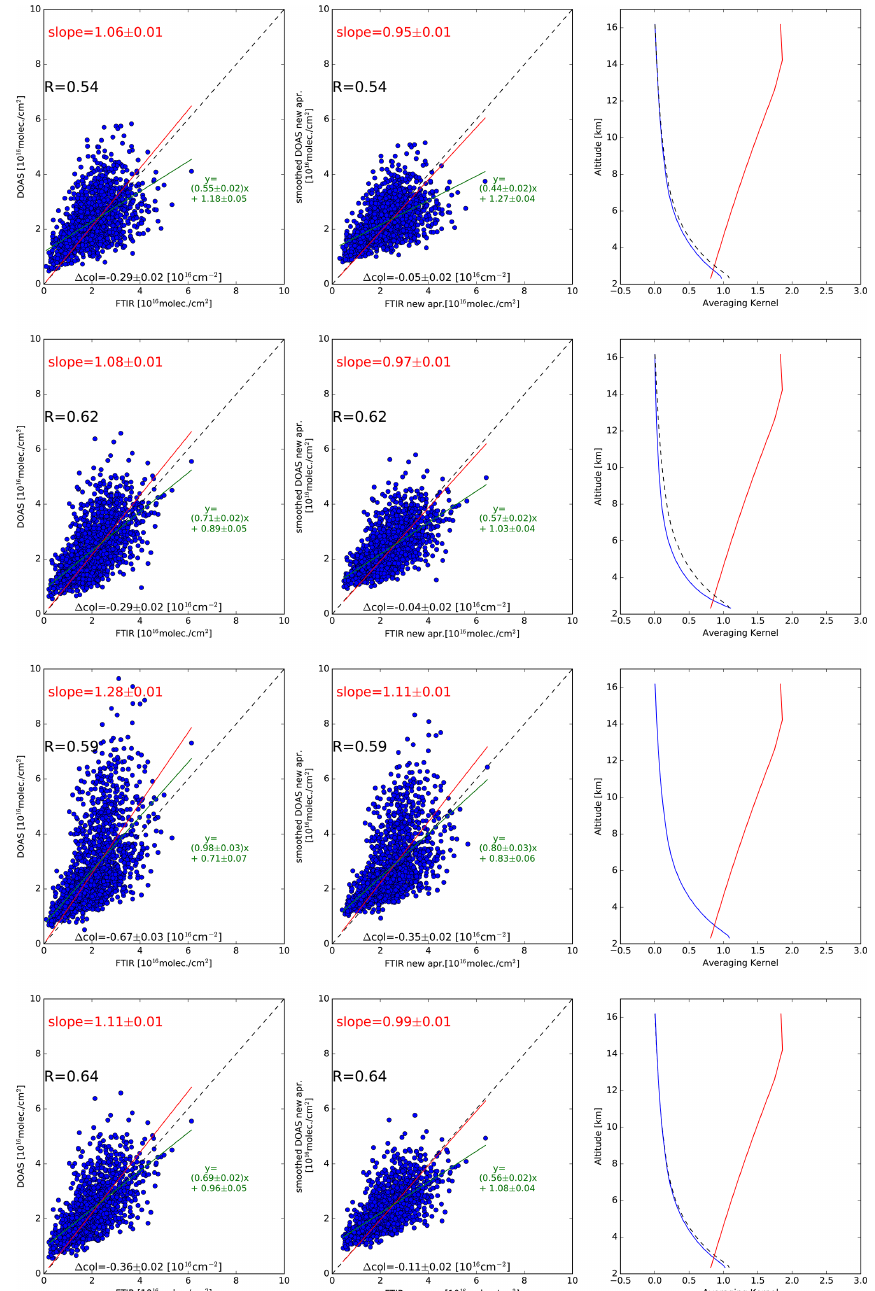
Figure 5. Comparison between FTIR and MAX-DOAS measurements conducted at the UNAM measurement site. The panels in the first and second rows correspond to the VCDs retrieved from MAX-DOAS measurements conducted towards the eastern (V1) and western (V2) measurement sides, respectively. For the third row panel, corresponding to the V3 data product, the VCDs are retrieved including both measurement sides. The panels in the fourth row correspond to the comparison between FTIR and MAX-DOAS V1 measurements during the morning and FTIR and MAX-DOAS V2 measurements during the afternoon. The linear regression when forced to zero (red) and not constrained (green) is presented. Black lines represent the 1 : 1 relation. The left column shows the direct correlation between coincident pairs, whereas the middle column compares the retrieved FTIR VCDs with those calculated from the smoothed MAX-DOAS profiles using the averaging kernel from the FTIR instrument (see text). The right column shows the total column averaging kernel of the FTIR (red lines) and MAX-DOAS (blue lines) retrievals. The dashed black lines on the first, second and fourth rows represent the averaging kernel of V3. A priori: